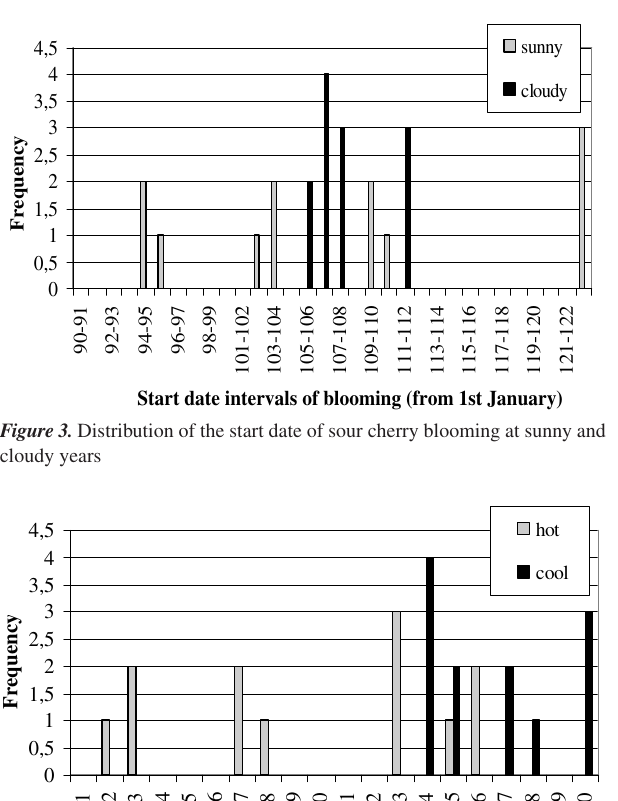
Figure 2. Distribution of start date of blooming at the examined cultivars (Újfehértó